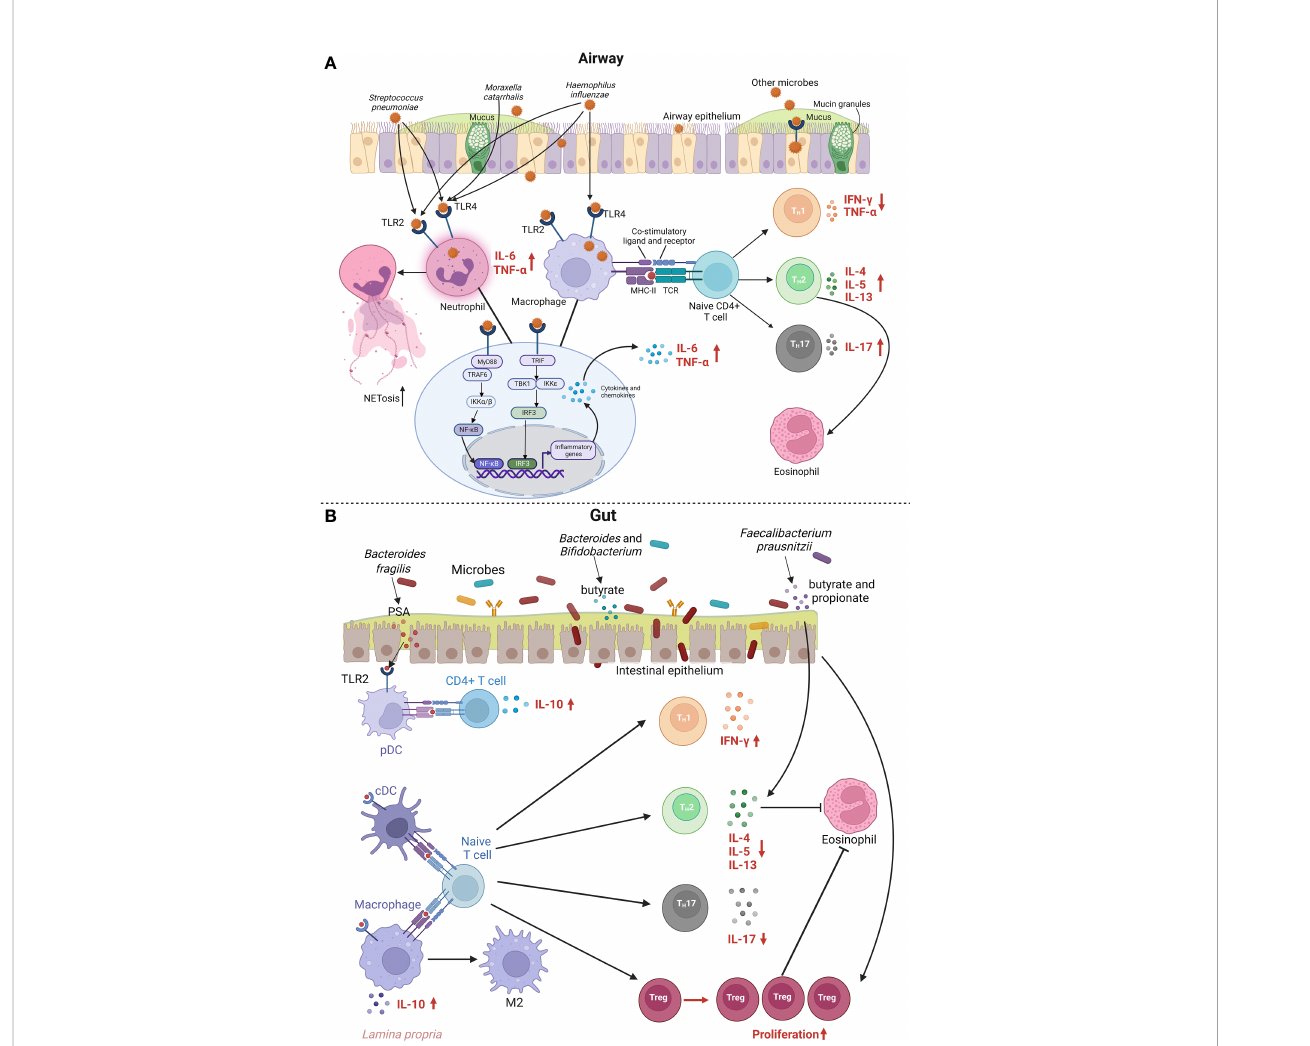
FIGURE 2 Metabolic and immune mechanisms for the link between airway or gut microbiota and asthma. (A) shows immune mechanisms for the airway epithelial cell signaling in response to bacterial pathogens. Various bacterial pathogens bind to innate sensors TLR2 and TLR4 and further activate MyD88- and TRIF-dependent pathways. MyD88 recruits TRAF6, which further activates the IKK complex, allows NF- к B to translocate into the nucleus, and leads to the overall production of in fl ammatory cytokines and chemokines, and activation of T cells. Additionally, recognition of various bacterial pathogens activates the TRIF-dependent signaling pathway, which involves the recruitment of TRIF, that leads to subsequent activation of TBK1 and IKK ϵ along with induction of transcription factor IRF3. This signaling pathway results in interferon-related cytokines, and can potentiate NF- k B gene transcription. Enhanced neutrophil TLR2 and TLR4 signaling by bacterial pathogens promote neutrophils cytokine production and NETosis, a program for formation of NETs. Bacterial pathogens can also be recognized by TLR2 and TLR4 on macrophages, leading to activation of NF- k B and IRF3 signaling pathway and secretion of in fl ammatory mediators. Macrophages can also function as APC and regulate T cell activation. The T cell is presented an antigen with MHC II by APC. The recognition of the antigen-MHC II complex and the co-stimulatory molecules activates the T cell and leads downstream to differentiation into T H 2 and T H 17 cells, that can release various cytokines such as IL-4, IL-5 and IL-13, which lead to eosinophilic in fl ammation. APC, antigen-presenting cell; IKK, inhibitory kappa B kinases; IL, interleukin; IRF3, interferon regulatory factor 3; MHC, major histocompatibility complex; MyD88, myeloid differentiation primary response protein 88; NETosis, neutrophil extracellular trap formation; NETs, neutrophil extracellular traps; NF- к B, nuclear factor kappa B; TBK1, TANK-binding kinase 1; T H 2, T helper 2; T H 17, T helper 17; TLR, Toll-like receptor; TRAF6, tumor necrosis factor receptor associated factor 6; TRIF, TIR-domain-containing adapter-inducing interferon- b . (B) shows metabolic and immune mechanisms for the link between gut microbiota and asthma. PSA from Bacteroides fragilis induces and ligates TLR2 on pDC, which stimulate anti-in fl ammatory cytokine IL-10 secretion by CD4 + T cells. cDC and macrophage bound by gut microbiota show impaired ability to promote TH2- and TH17-type responses and tend to promote TH1-type responses and Treg proliferation, which lead to decreased eosinophilic in fl ammation. IL-10 dependent reprogramming of tissue macrophages is also essential for resolving in fl ammation by promoting M2 macrophage polarization. Bacteroides and Bi fi dobacterium can digest the fi ber and produce SCFAs, such as butyrate. Faecalibacterium prausnitzii increases SCFAs level, such as butyrate and propionate, which leads to reduced levels of IL-4, IL-5 and IL-13, and elevated level of Tregs. cDC, classical dendritic cell; IFN, interferon; IL, interleukin; pDC, plasmacytoid dendritic cell; PSA, polysaccharide A; SCFAs, short-chain fatty acids; T H 2, T helper 2; T H 17, T helper 17; TLR, Toll-like receptor; Treg, regulatory T